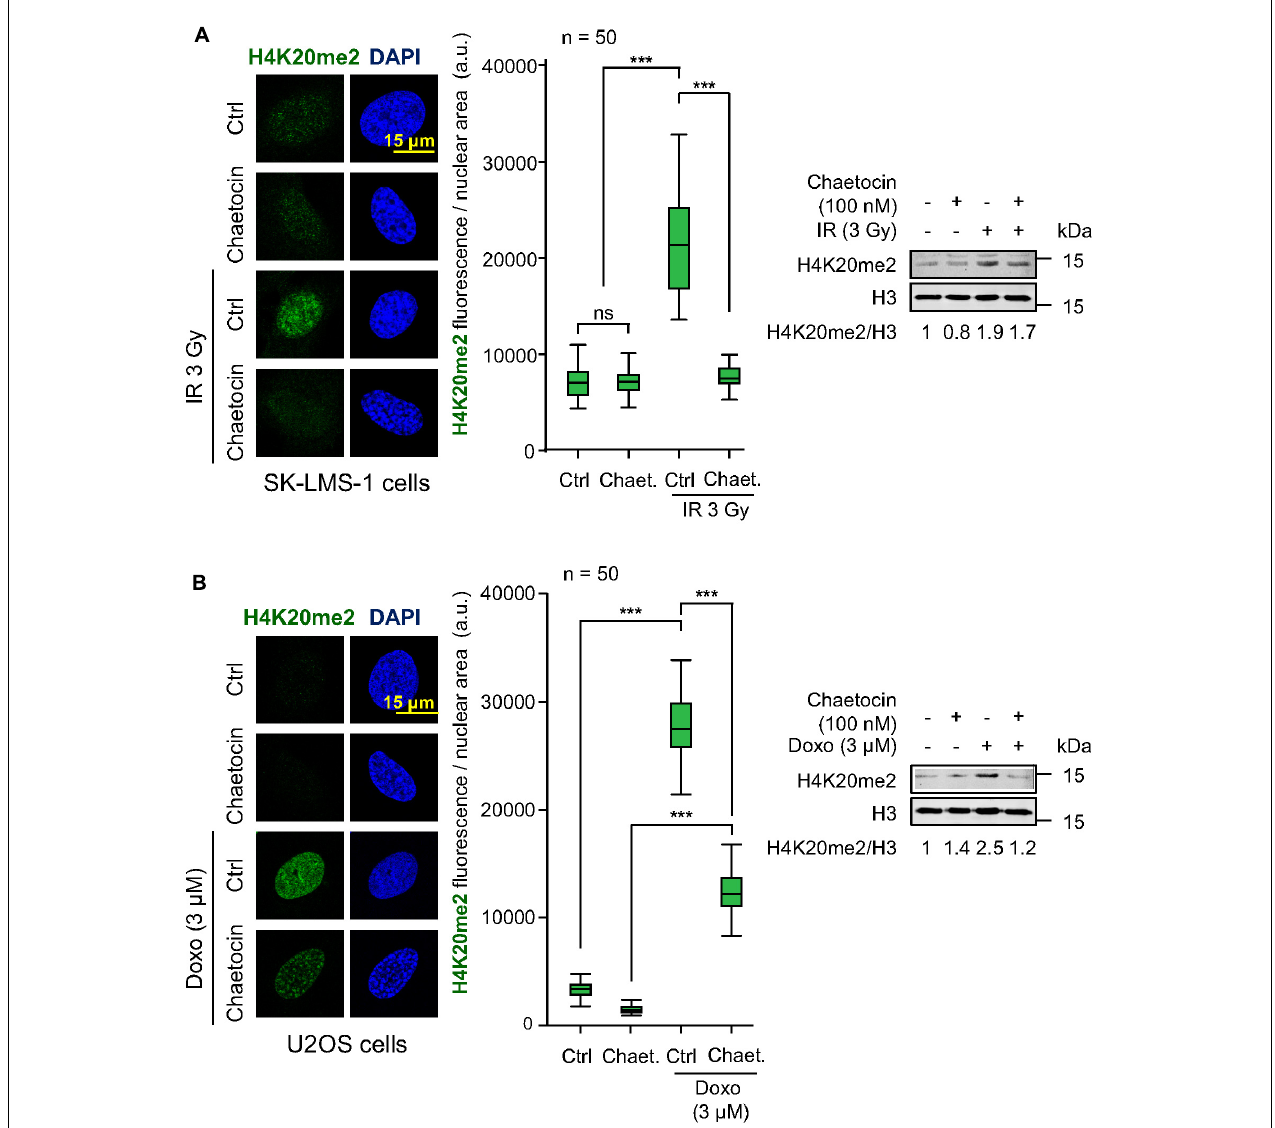
FIGURE 4 | Effect of chaetocin on H4K20me2 induced by IR or doxorubicin. (A) Effect of chaetocin on H4K20me2 induced by IR in SK-LMS-1 cells. (B) Effect of chaetocin on H4K20me2 induced by doxorubicin in U2OS cells. Quantification of nuclear fluorescence associated with H4K20 dimethylation in response to chaetocin, IR, doxorubicin or their combination (center). Analysis of H4K20me2 levels by western blot (right). Ctrl, control without IR or doxorubicin, as appropriate. ns, not significant, *** p < 0.001. These images only show the detail in one cell selected for presentation. The field images are shown in Supplementary Figure 6 . Ctrl, control without chaetocin. Chaet, chaetocin (100 nM).